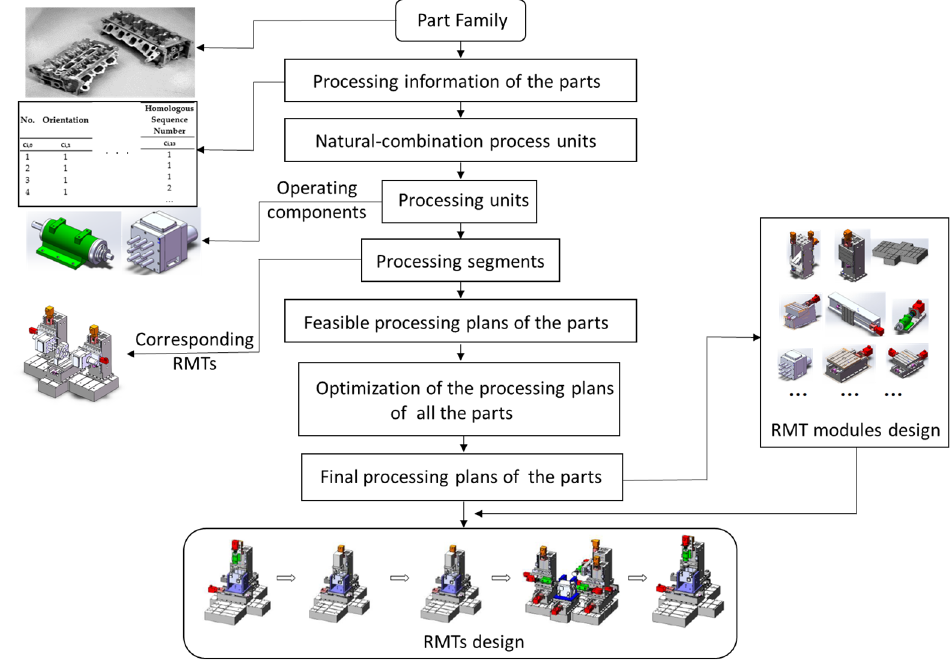
Figure 4. The general scheme of the design methodology of reconfigurable machine tools.